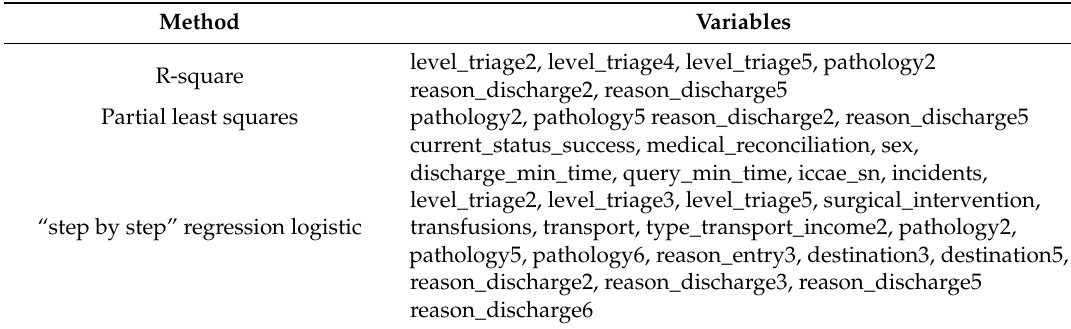
Table 7. Selection of imputed data.